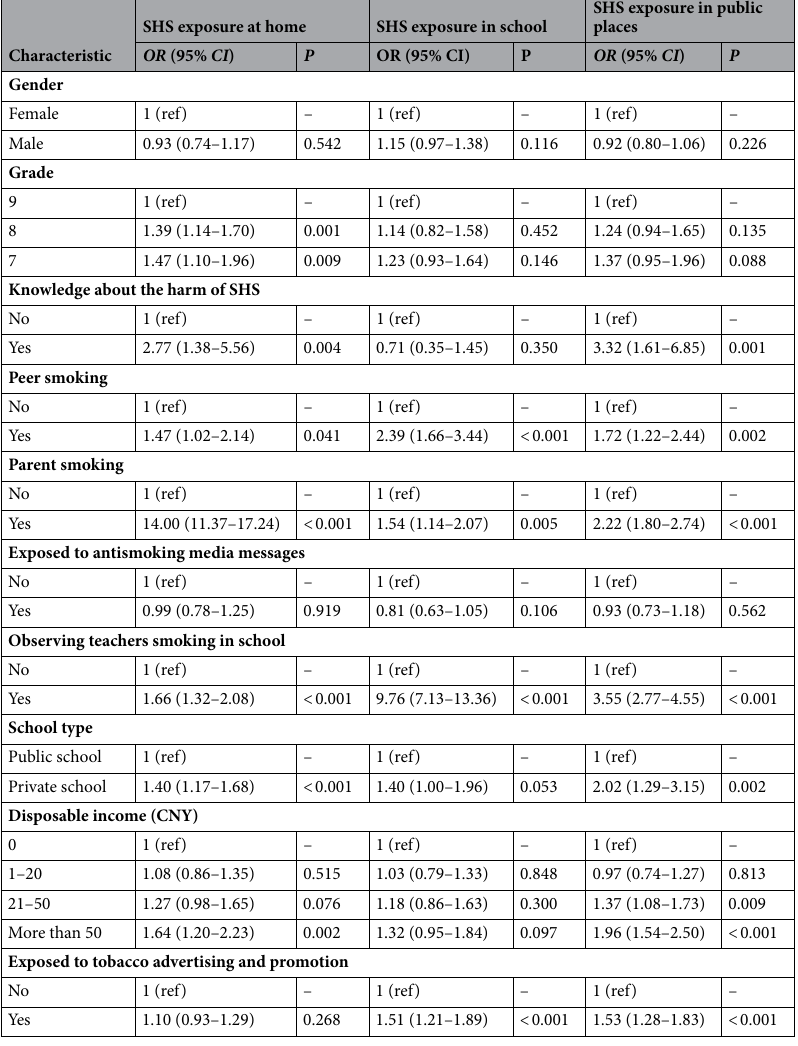
Table 4. Risk factors of secondhand smoke (SHS) exposure among never-smoking adolescents (Weighted). SHS secondhand smoke, CNY Chinese Yuan, 1 United States dollar = 6.7 Chinese yuan, OR odds ratio, CI confidence interval, ref referent